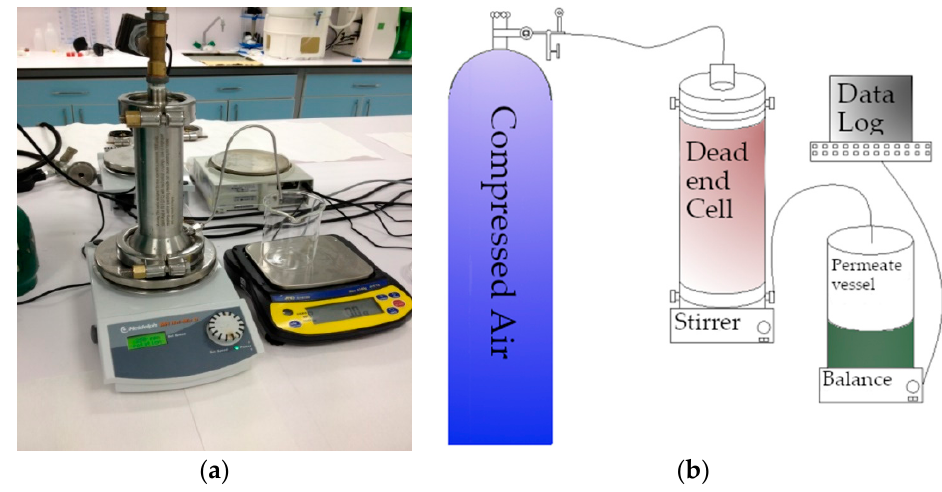
Figure 3. View of permeability test ( a ) experimental set-up ( b ) schematic diagram. First, the compression process is applied to the synthesised membranes at 5 bar pressure for 30 min until their flux values stabilised. After the compression process, pure water filtration is carried out for 11 min at three different pressure values (1, 1.5, and 2 bar). The experiments are repeated three times for each membrane at all pressure values. The average flux value of each membrane is calculated using Equation (2).